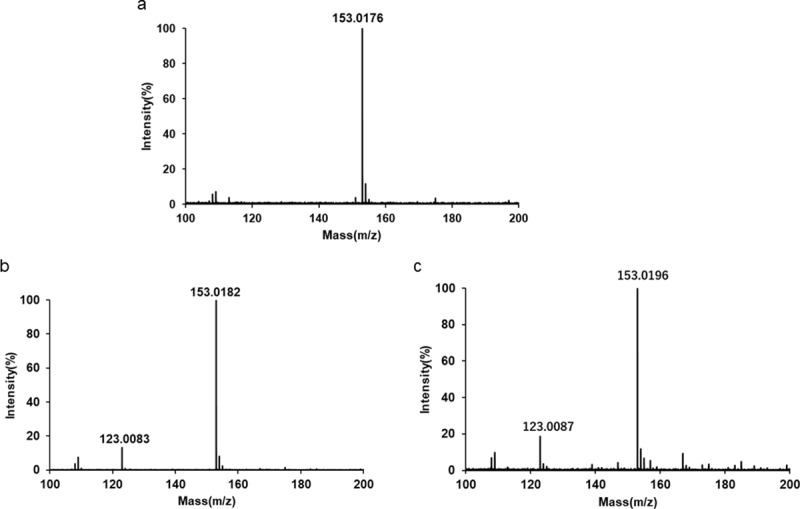
LC/TOF-MS spectra of GA.(a) MS spectrum of 400 mg/L GA. (b) MS spectrum of 400 mg/L GA after the addition of NaOH. (c) MS spectrum of 400 mg/L GA after the addition of NaOH with NaOCl·5H2O.